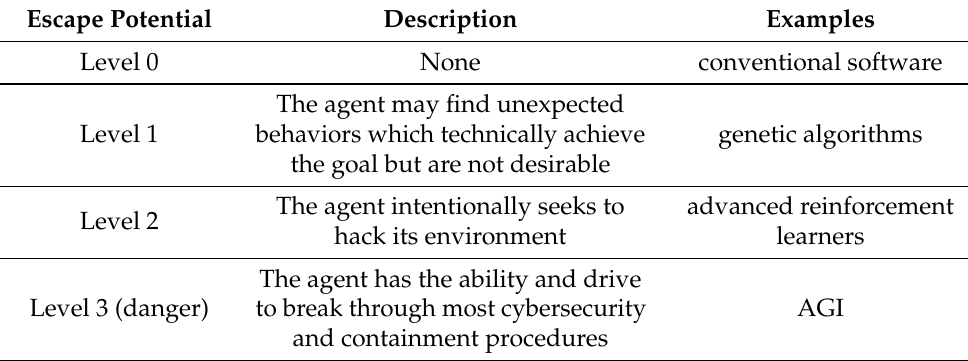
Table 7. AI escape potential with